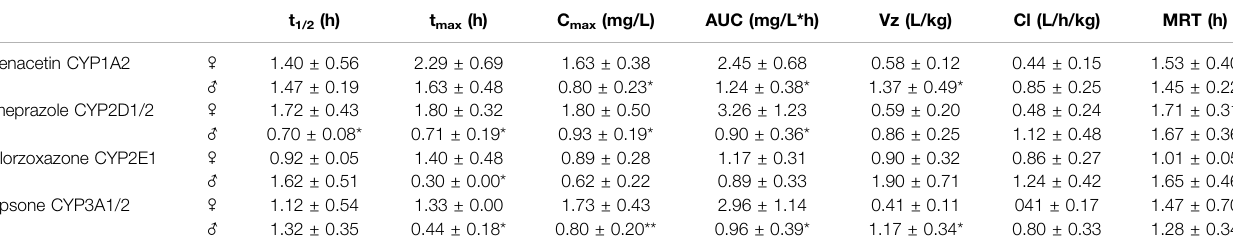
TABLE 4 | Relative pharmacokinetic parameters of probe substances in male and female rats exposed to